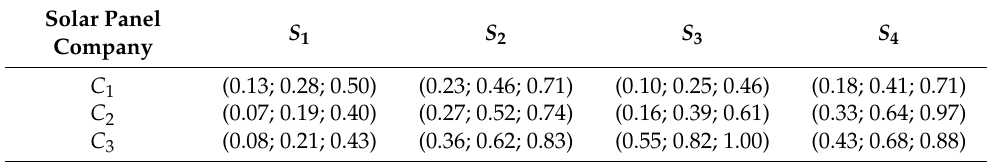
Table 15. Fuzzy weighted normalized decision matrix for M 1